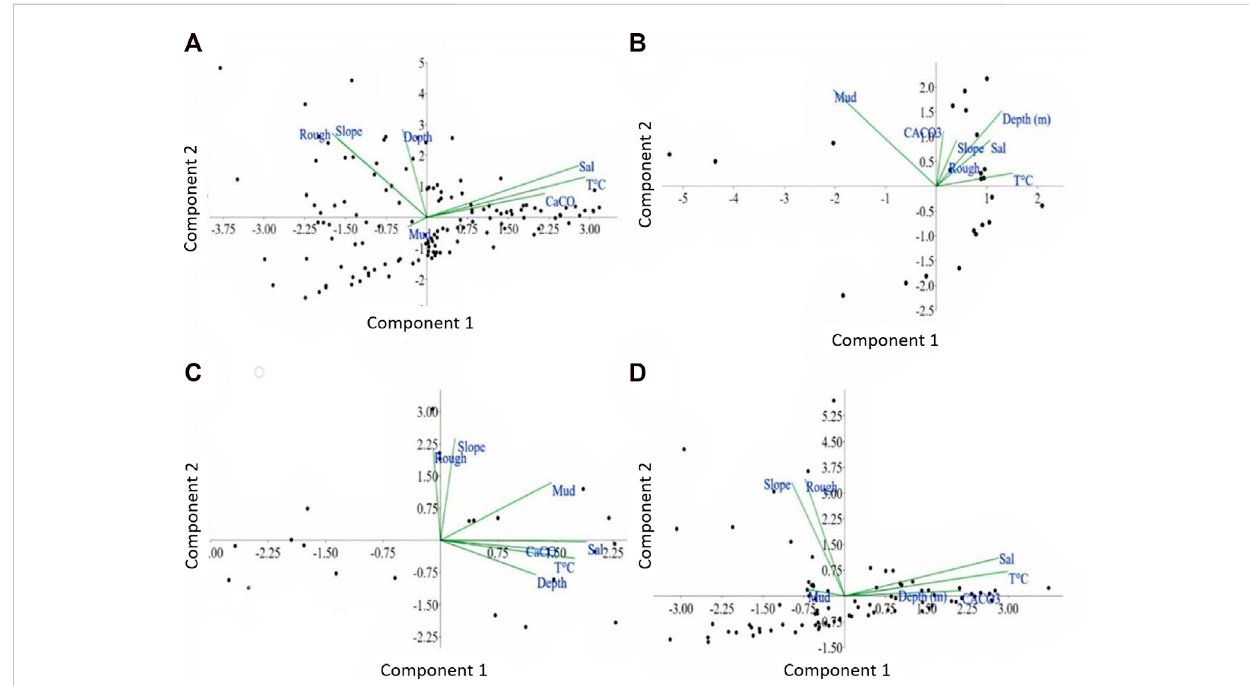
FIGURE 12 PrincipalComponentsAnalysisresults: (A) Integratedanalysis(valleybottom, fl anksandvalleyadjacenciesareas; (B) Valleybottom; (C) Valley fl anks; (D) Valley Adjacent